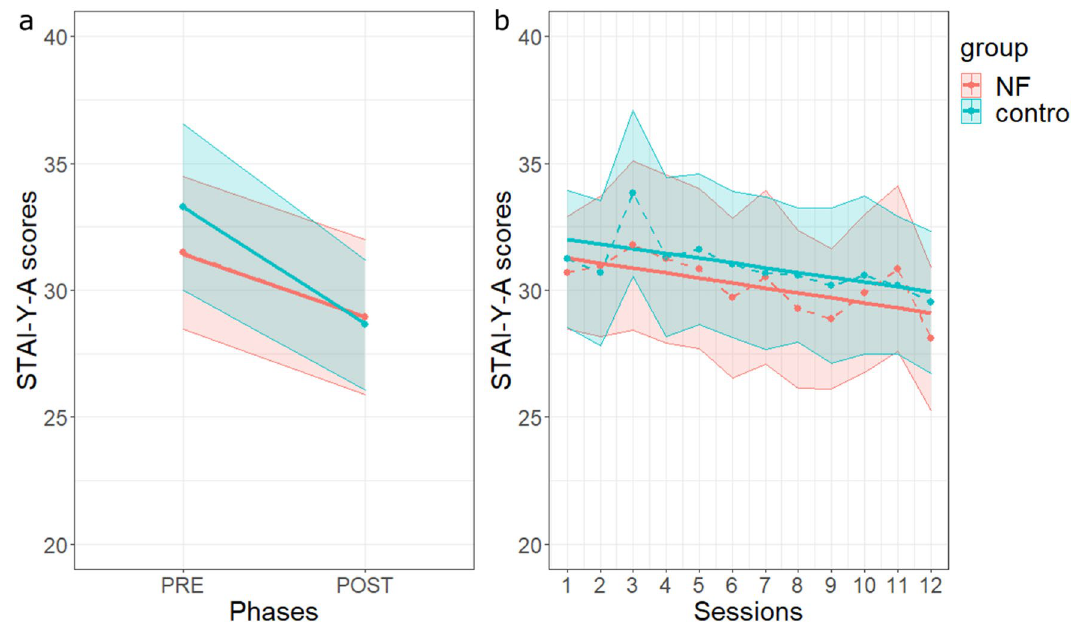
Figure 5. Effects of NFT on anxiety level. ( a ) Pre-post (phase) mean effects. Evolution of the STAI-Y-A scores from pre- to post-NF training sessions, averaged across participants and sessions, for the NF (in red) and control (in blue) groups. Shaded areas represent standard errors of the means. ( b ) Between-session effect on STAI-Y-A scores in each group. For each session, the pre- and post-session anxiety levels were averaged. Same legend as in Fig. 3a. Graphs were obtained with R software (v.4.0.2; R Core Team,